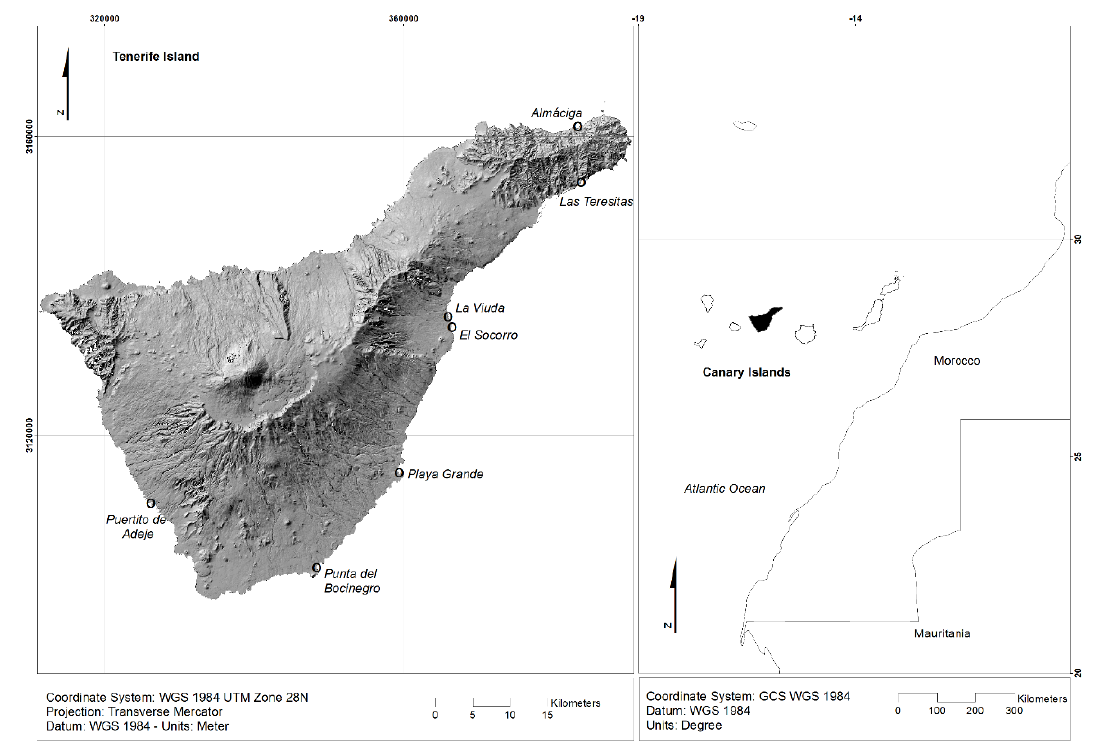
Figure 1. Location of the Canary Islands highlighting the island of Tenerife, located in the Atlantic Ocean and geolocation of the beaches sampled on the island of Tenerife. Table 1. Data on beaches locations and characteristics, as well as sampling dates.